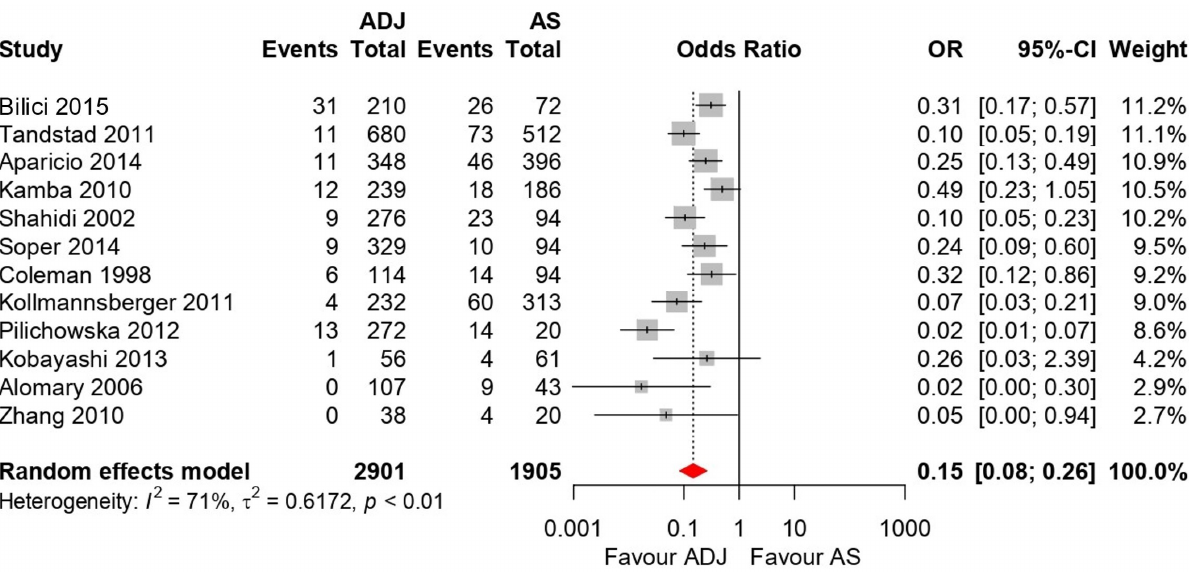
Figure 4. Forest plots for 5-year recurrence-free suvival (RFS) comparing active surveillance (AS) and adjuvant therapy [12–15,17–19,21–25]. Adjuvant radiotherapy or chemotherapy reduces the risk of 5-year recurrence by 85% versus AS (odds ratio, 0.15; 95% confidence interval, 0.08–0.26; p < 0.001).